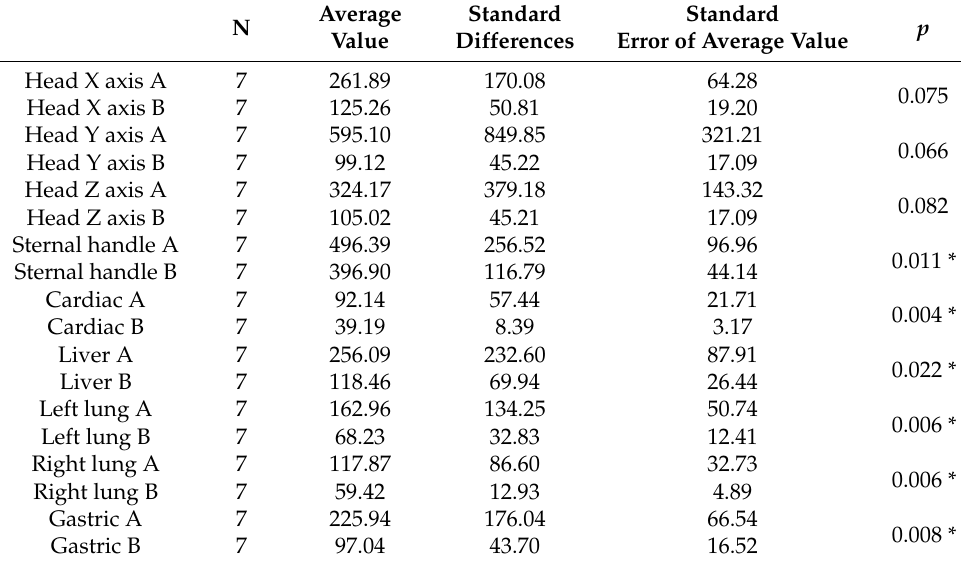
Table 3. Comparative analysis of the acceleration of hitting the dummy (unit: m/s 2 ; A is the master group; B is the beginner